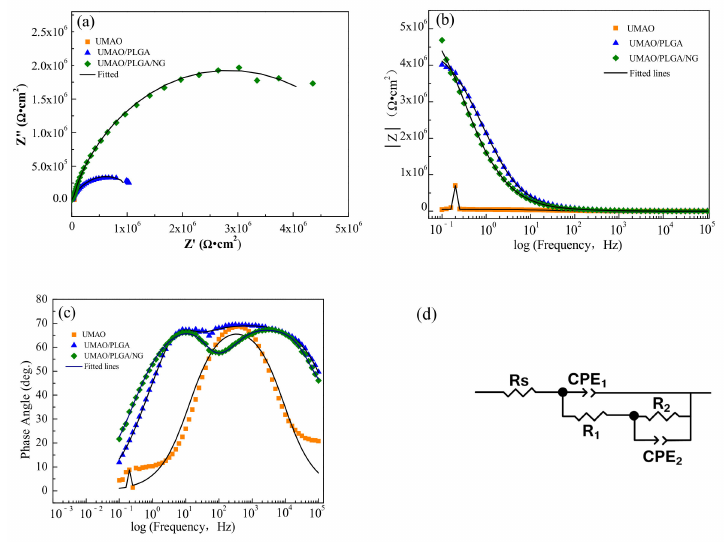
Figure 7. ( a ) Nyquist plots, ( b , c ) Bode plots, and ( d ) equivalent circuit of the different coatings. The Bode and fitting plots of the UMAO, UMAO/PLGA, and UMAO/PLGA/NG coatings are shown in Figure 7b. There are two time-constants in the UMAO coating, which respond to UMAO coating and substrate magnesium, respectively. The UMAO/PLGA and UMAO/PLGA/NG coatings have similar Bode plots. The low-frequency and high- frequency time constants are the response of the UMAO and PLGA layers, respectively.